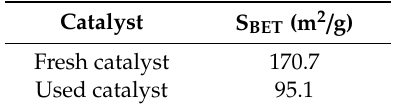
Table 2. BET surface area of the fresh and used